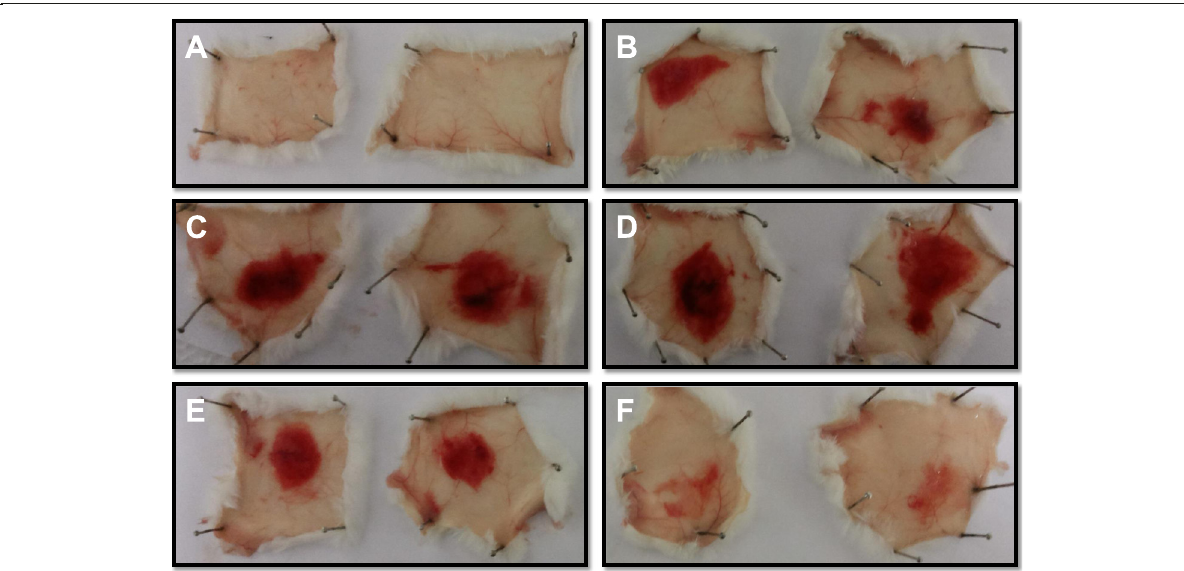
Fig. 9 Evaluation of the hemorrhagic activity of the MP from B. atrox venom. Samples (n = 2) were injected intradermally into the back of BALB/c mice, and after three hours, the animals were euthanized and had their skins removed to allow the observation of the presence or absence of hemorrhagic halos. Samples (halo diameter): ( a ) PBS (0 mm), ( b ) MP 5 μ g (10 mm, determined as the MHD), ( c ) MP 10 μ g (16